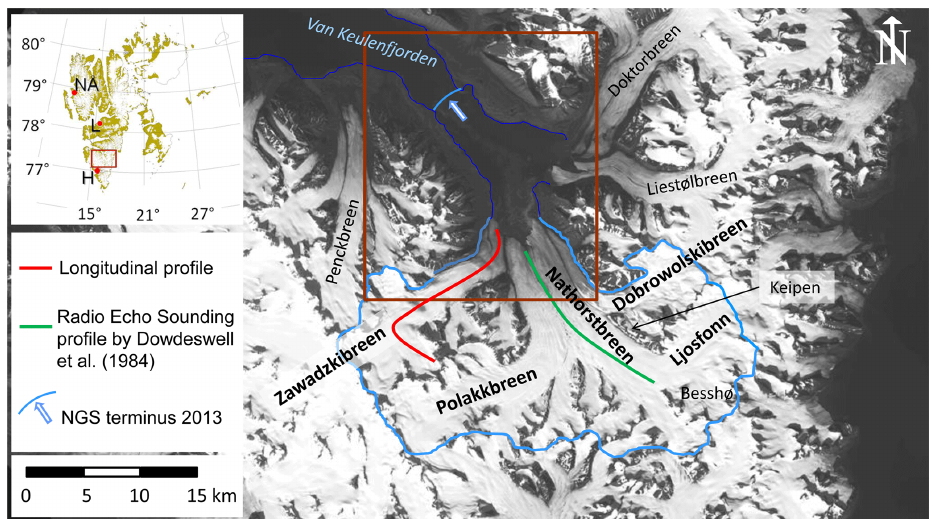
Fig. 1. Inset map: main islands of Svalbard, with meteorological stations Ny-Ålesund (NÅ), Svalbard Lufthavn – Longyearbyen (L), and Hornsund (H). Nathorstbreen glacier system (blue outline) drains into Van Keulenfjorden. The red outline refers to Fig. 7. Background image: 1 September 2008 is from the Système Probatoire pour l’Observation de la Terre (SPOT) Stereoscopic survey of Polar Ice: Reference Images and Topographies (SPIRIT © ) programme, Centre National d’Etudes, France (2007), and SPOT image 2008, all rights